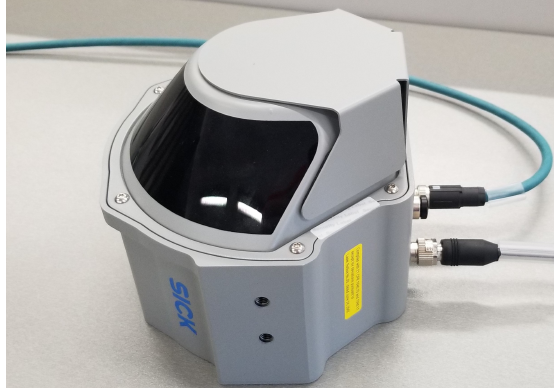
Figure 13. 3D LiDAR MRS 6000 by the SICK